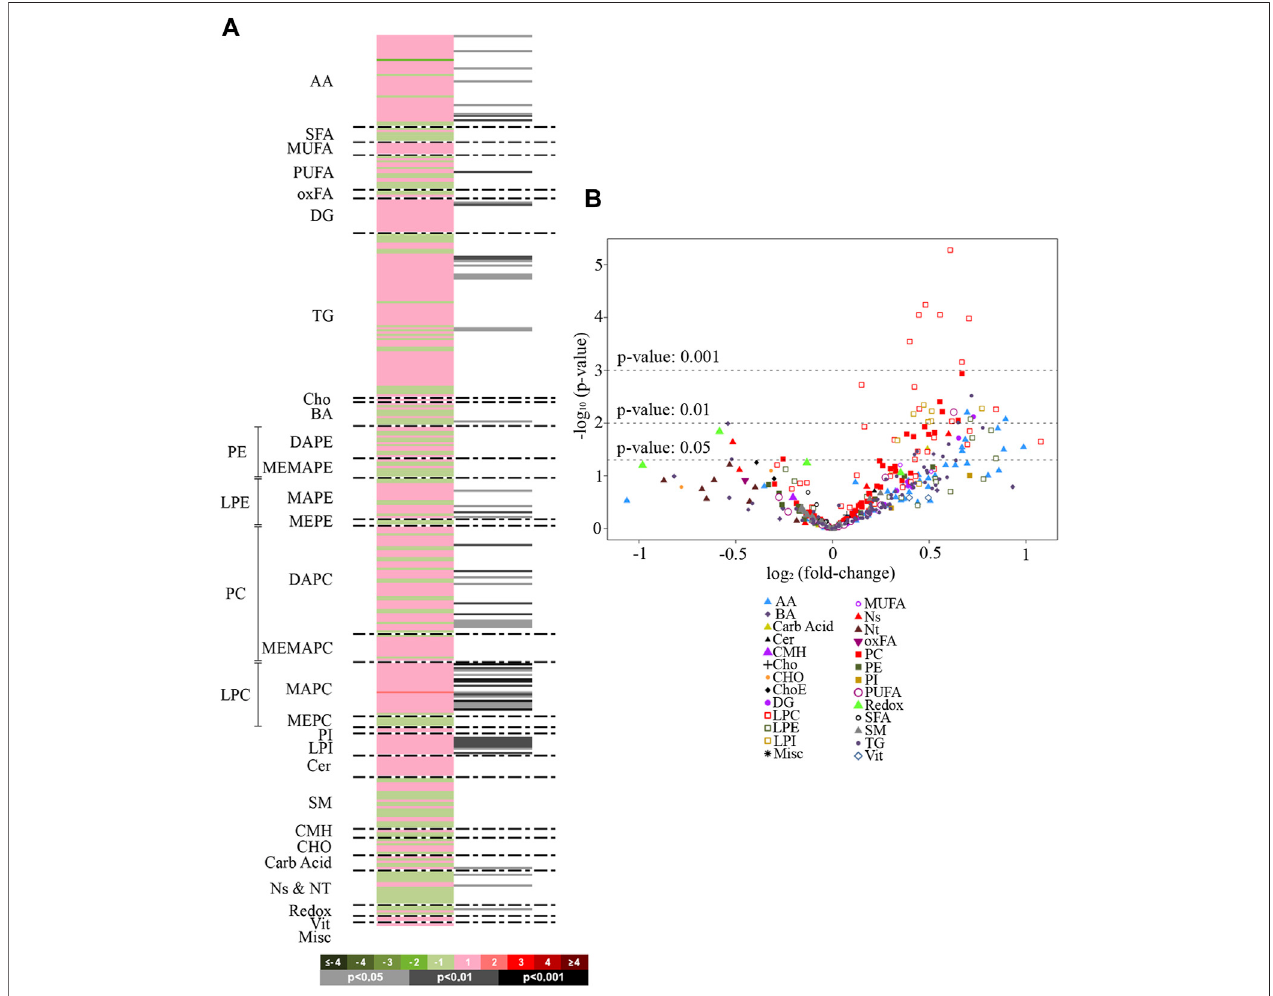
FIGURE 1 | Heat map and volcano plot. (A) : Heatmap representing individual metabolic features from rat livers treated with empagli fl ozin vs. control. Green sections of the heatmap denote reduced metabolites (negative log 2 fold-changes) and red sections denote metabolites increased (positive log 2 fold-changes). Grey/ black bars indicate signi fi cant p -values of the unpaired Student ’ s t-test (light grey, p < 0.05; dark grey, p < 0.01; black, p < 0.001). Metabolites are ordered according to their carbon number and unsaturation degree of their acyl chains. (B) : Volcano plot [-log 10 ( p -value) vs. log 2 (fold-change)] for the comparison empagli fl ozin vs. control. The graph shows the most signi fi cant ( p < 0.001 and p < 0.01) metabolites considered individually. AA, amino acids; SFA, saturated fatty acids; MUFA, mono- unsaturated fatty acids; PUFA, polyunsaturated fatty acids; oxFA, oxidized fatty acids; DG, diacylglycerides; TG, triacylglycerides; Cho, cholesterol; BA, bile acids; PE, phosphatidylethanolamines; DAPE, diacylglycerophosphatidylethanolamines; MEMAPE, 1-acyl,2-etheracylglycerophosphatidylethanolamines; LPE, lysophosphatidylethanolamines; MAPE, monoacylglycerophosphatidylethanolamines; MEPE, monoetherglycerophosphatidylethanolamines; PC, phosphatidylcholines; DAPC, diacylglycerophosphatidylcholines; MEMAPC, 1-acyl,2-etherglyceropho- sphatidylcholines; LPC, lysophosphatidylcholines; MAPC, monoacylglyceropho-sphatidylcholines; MEPC, monoetherglycerophosphatidylcholines; PI, phospatidylinositols; LPI, lysophosphatidylinositols; LPG, cardiolipins; Cer, ceramides; SM,sphingomyelin; CMH:monohexosylceramides,Carb Acid., carboxylic acids;Nsand Nt,nucleosidesand nucleotides;Redox, moleculesparticipating in redox homeostasis; Vit., vitamins; Misc., miscellany.